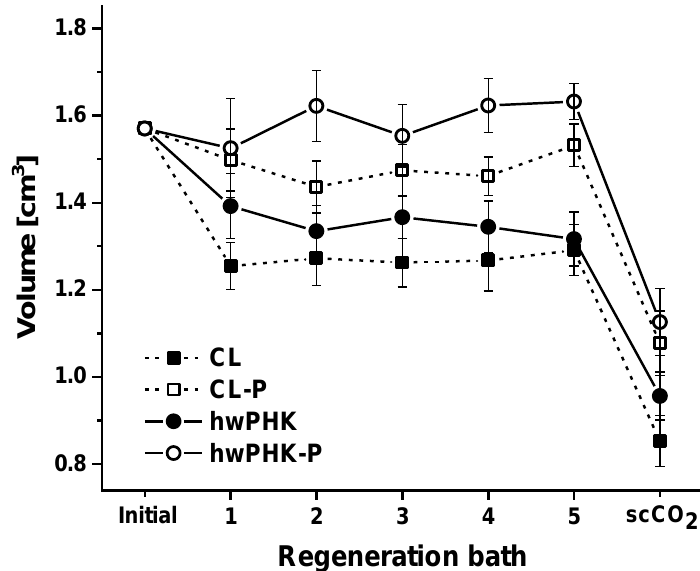
Figure 1. Change in volume of the gels during regeneration in ethanol followed by supercritical carbon dioxide (scCO 2 ) drying (-P indicates phosphorylated samples). Error bars indicate the 95% confidence interval.